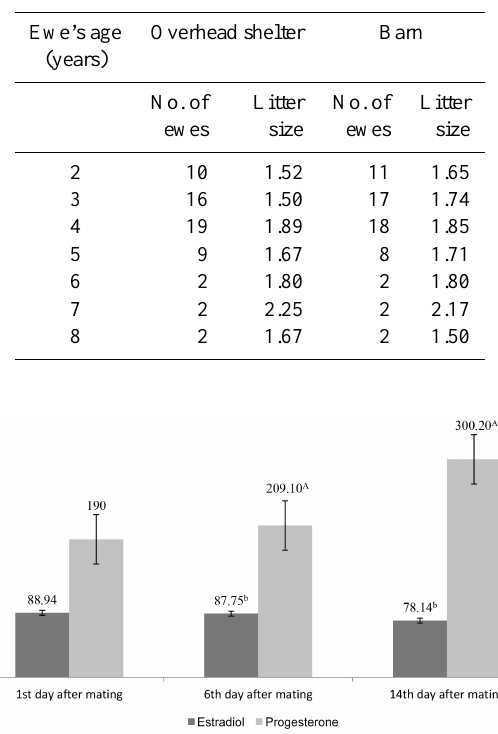
Table 2. The distribution of the number of ewes in the age groups and average litter size of the ewes by group and age.